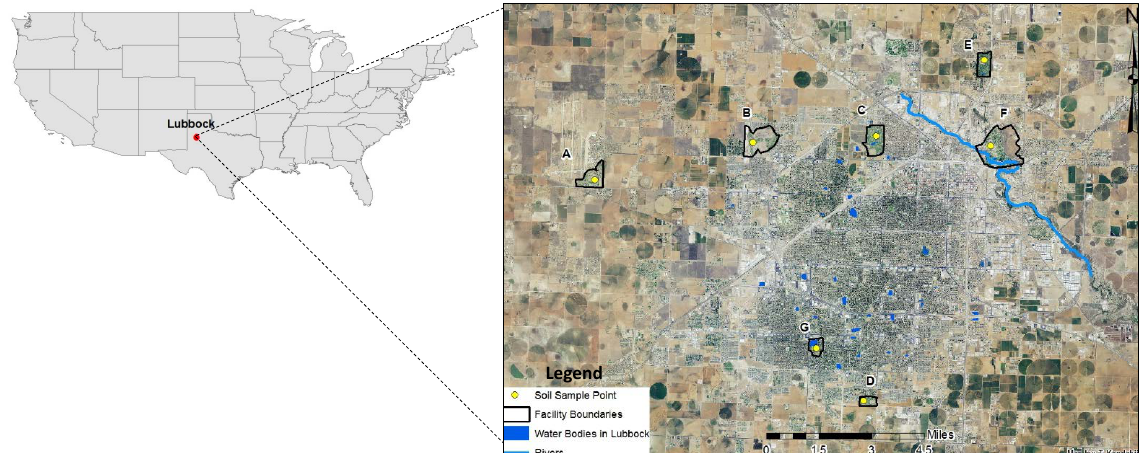
Figure 1. Map showing the study area located in Lubbock, Texas, USA, and the locations of the seven golf facilities. The facilities are designated as A, B, C, D, E, F, and G.